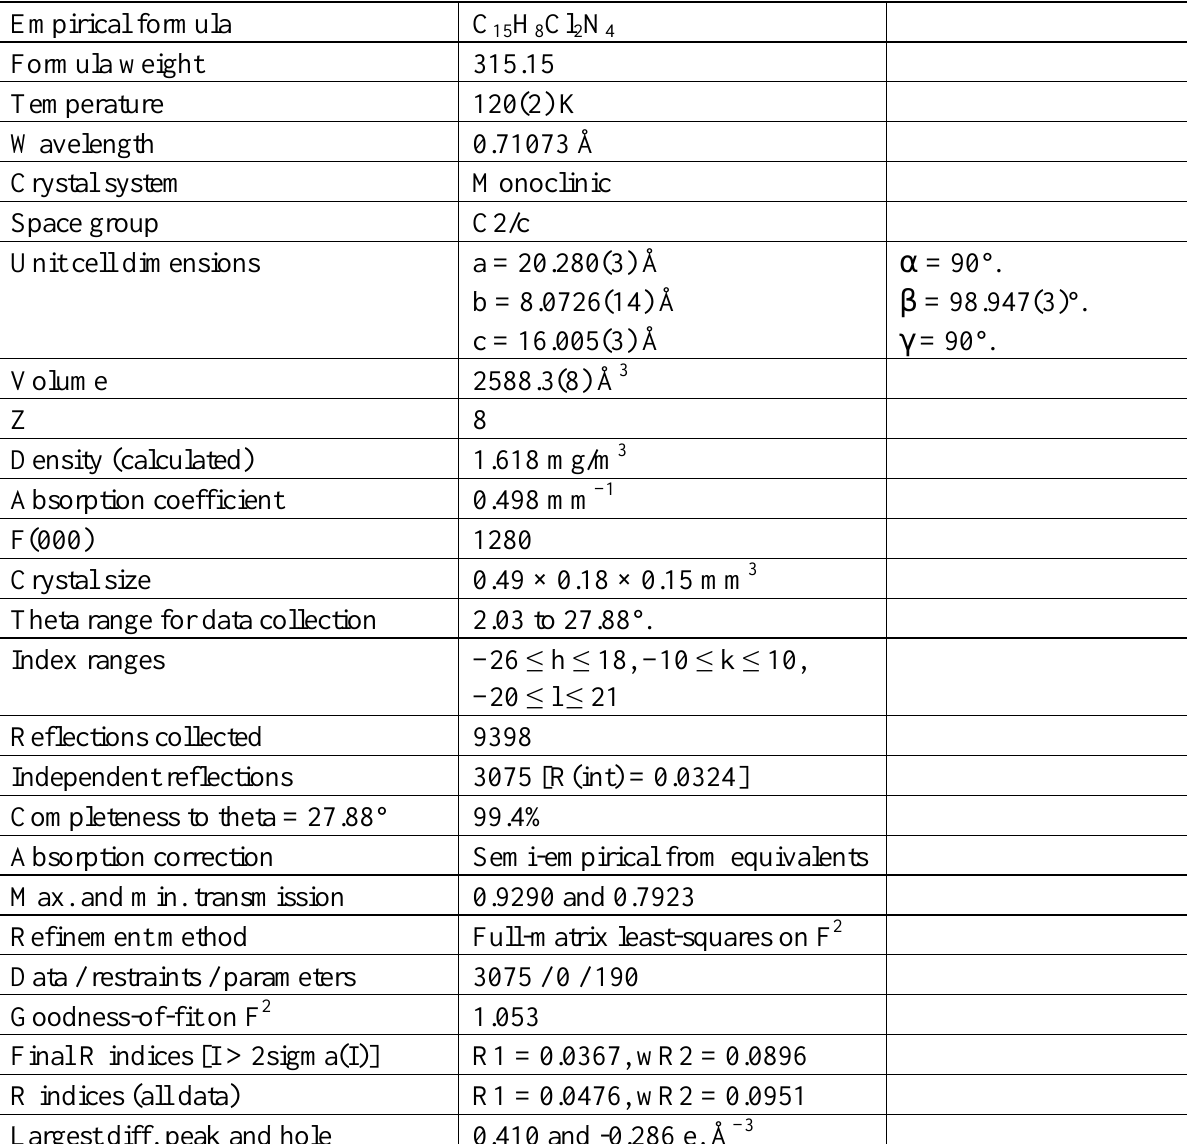
Table 1. Crystal data and structure refinement for ( 3